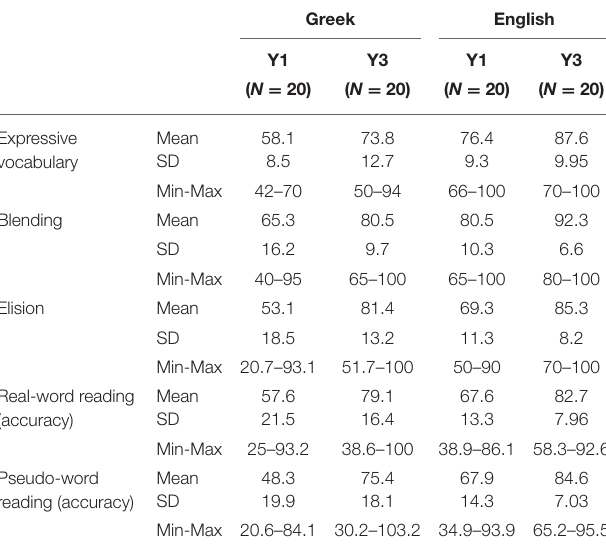
TABLE 3 | Descriptive statistics of the children’s performance on the Greek and English expressive vocabulary, phonological awareness (blending, elision), decoding (real-words, pseudo-word) tasks (percentage correct).